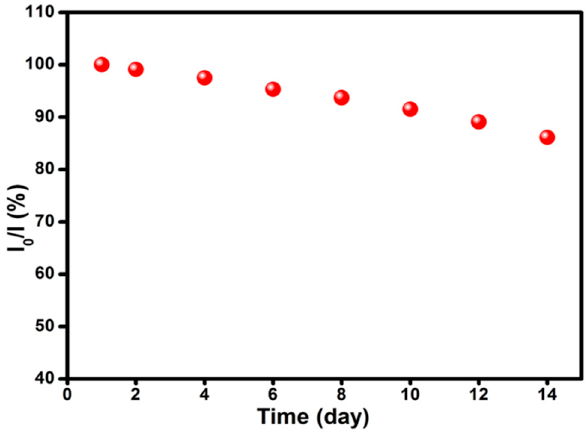
Figure 5. Stability of the sensor stored at ambient conditions over 14 days in 0.1 M NaOH glucose at potential of 0.13 V (vs. Ag/AgCl).